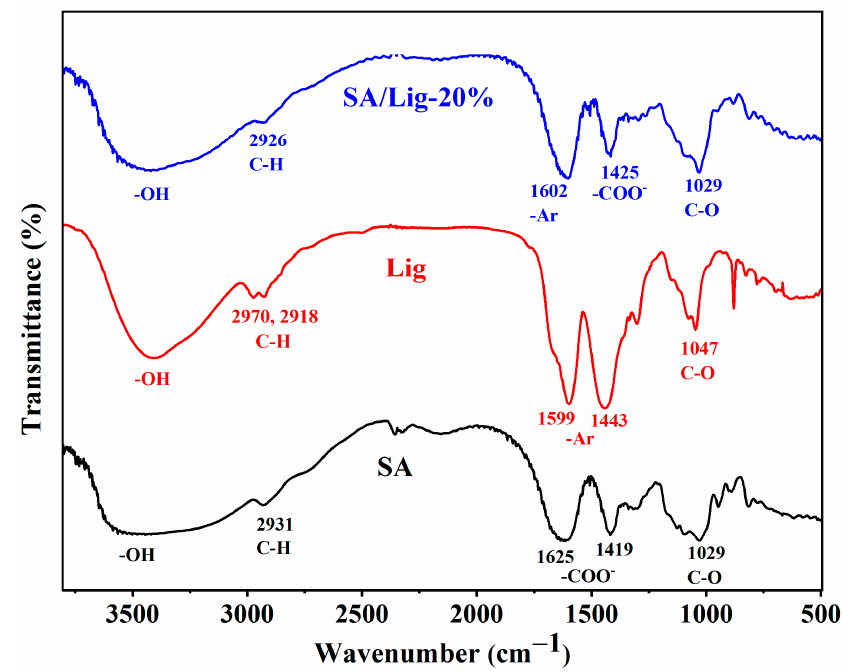
Figure 2. FTIR spectra of SA, Lig, SA/Lig-20% beads.